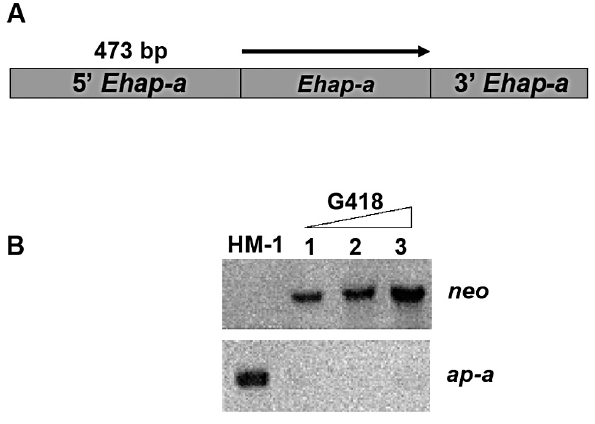
Fig. 1. – (A) Schematic diagram of plasmid psAP-1. The plasmid contains the Ehap-a gene with its 5’ upstream region of 473 bp and its 3’ regulatory region. The distal region of the 5’ 473 bp segment contains the truncated SINE element that is transcribed in the oppo- site orientation (Anbar et al ., 2005). (B) Northern blot analysis of amoebic RNA extracts. Lanes 1-3 are HM-1:IMSS trophozoites trans- fected with plasmid psAP-1 and grown in the presence of increa- sing concentrations of the neomycin derivative, G418, used as the selective marker. The probes used are as